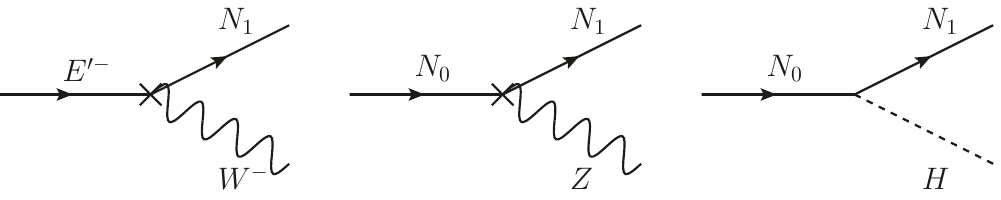
Figure 11 . Main production channel of the electroweak doublets L = ( E 0(cid:0) ; N 0 ) at a proton collider. Arrows indicate the (cid:13)ow of the new conserved U(1) fermion number.